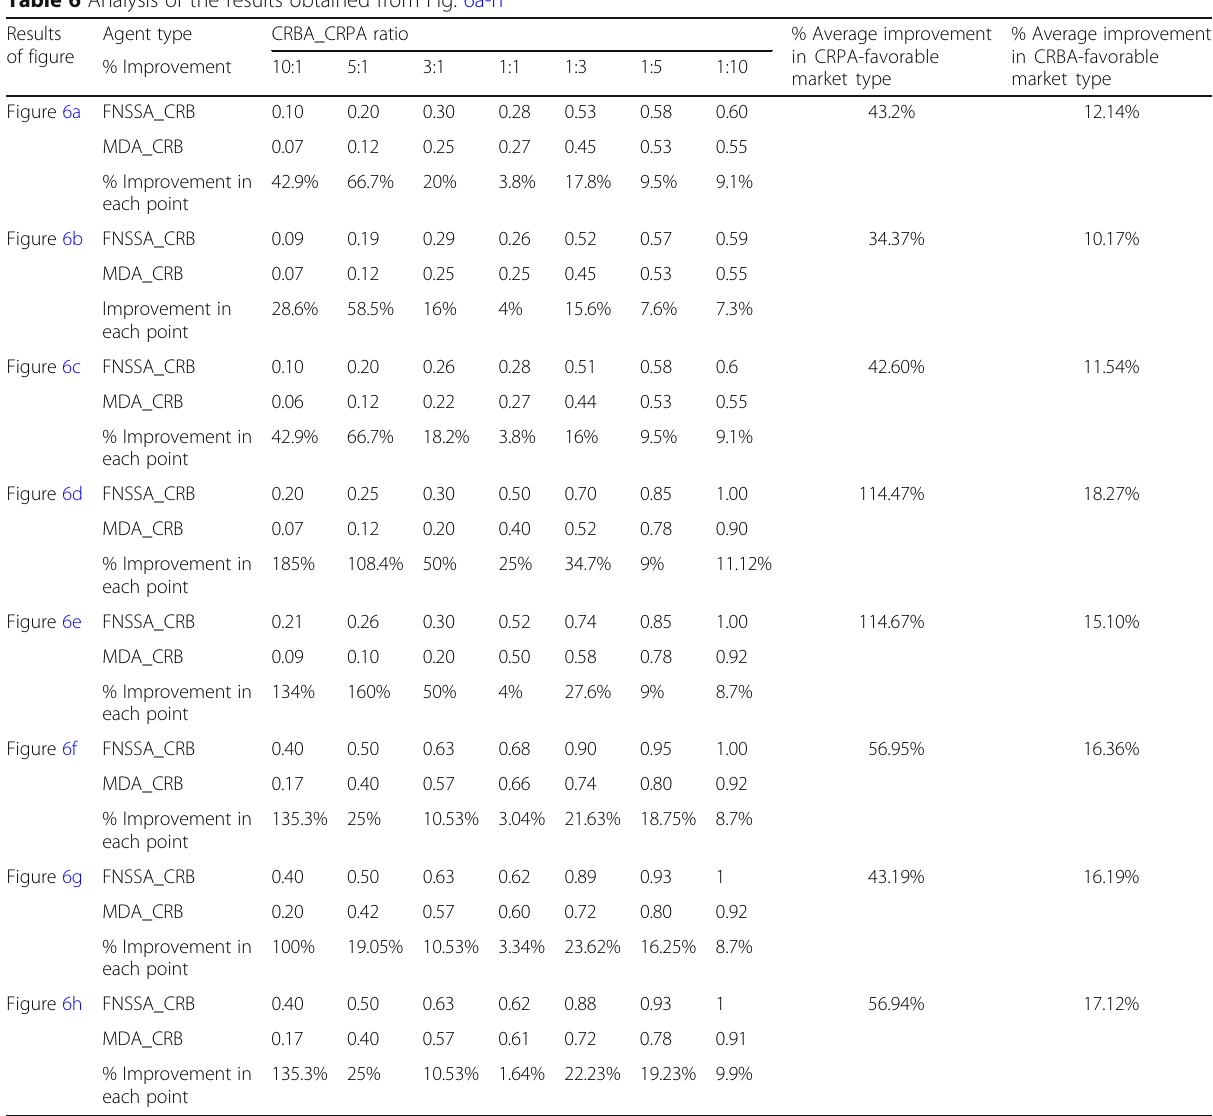
Table 6 Analysis of the results obtained from Fig. 6a-h Results of figure Figure 6a FNSSA_CRB